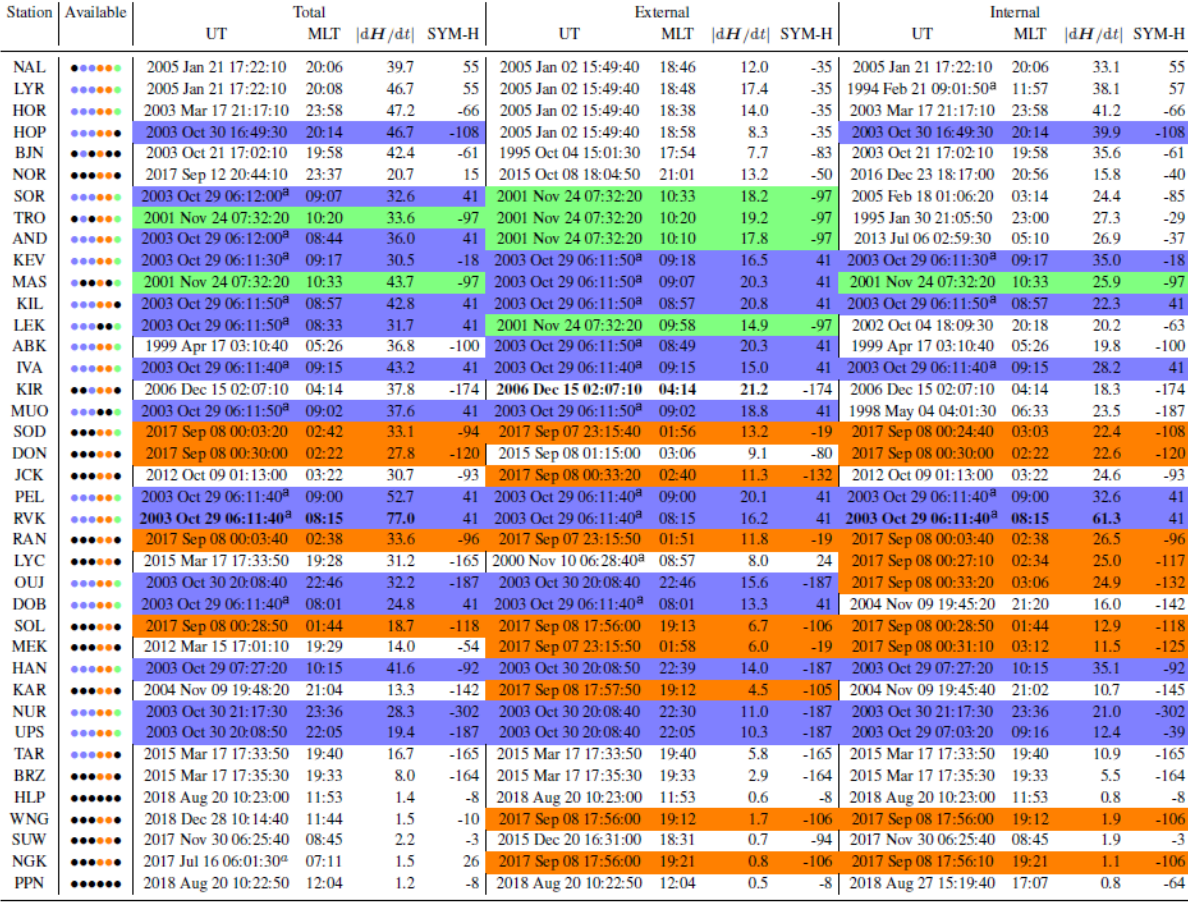
Table 2. Minimum, maximum, median, mean, and standard deviation (SD) of the external, internal, and total | d H / d t | from Table 1. Min [nTs − 1 ] Max [nTs − 1 ] Median [nTs − 1 ] Mean [nTs − 1 ] SD [nTs − 1 ] External | d H / d t | 0.5 21.2 Internal | d H / d t | 0.8 Total | d H / d t